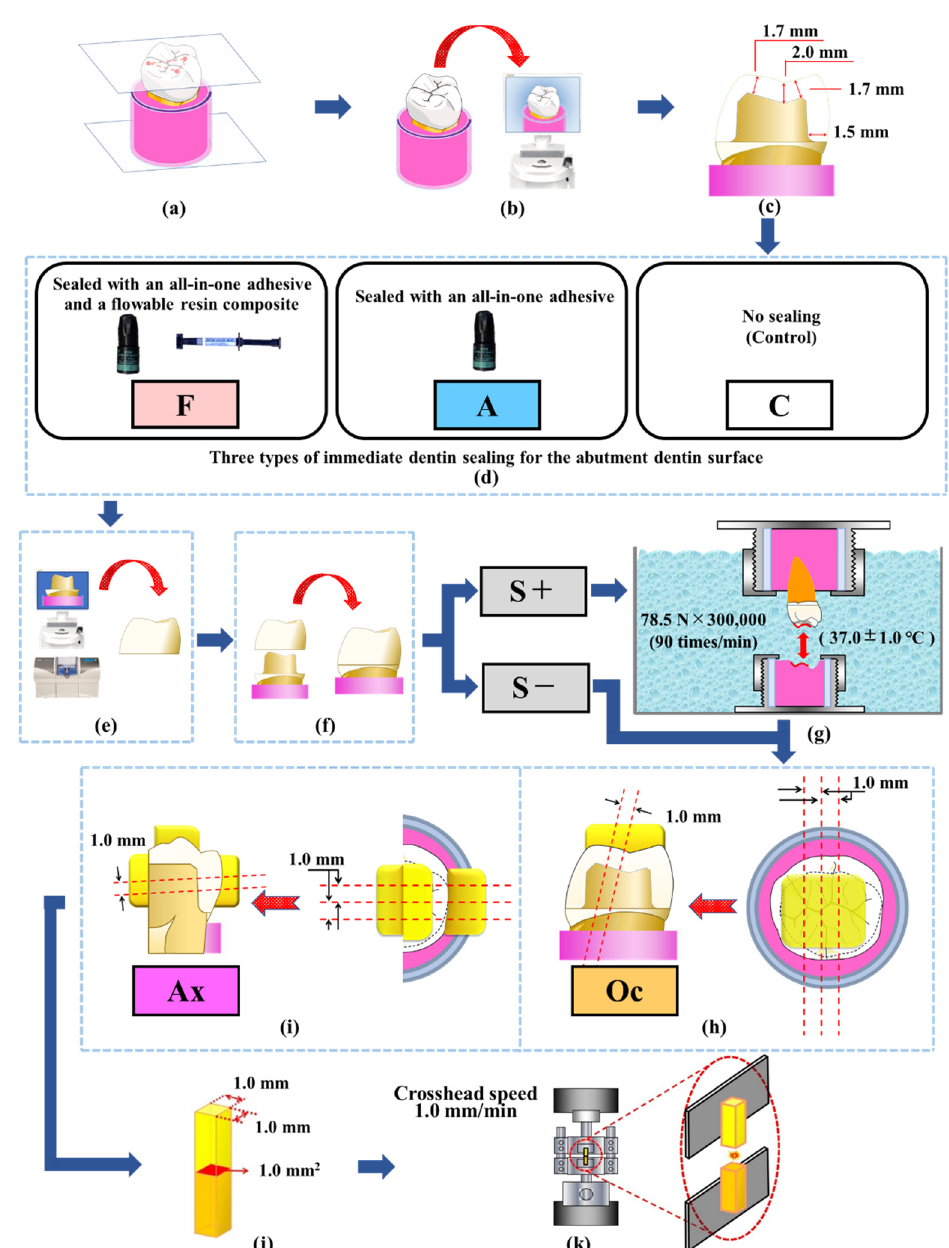
Figure 1. Flowchart of the experimental procedure. ( a ): Standardized tooth embedding, ( b ): Scanning of intact coronal form, ( c ): Standardized abutment preparation, ( e ): Fabrication of CAD/CAM ceramic crown, ( f ): Luting of fabricated crown, ( g ): Cyclic loading of 78.5 N; total, 3 × 105 cycles; 90 cycles/min in circulating water at 37 °C, ( h - j ): Sectioning in order to obtain the micro-tensile bond strength ( μ TBS) beam specimen, ( k ): μ TBS measurement at a crosshead speed of 1.0 mm/min.